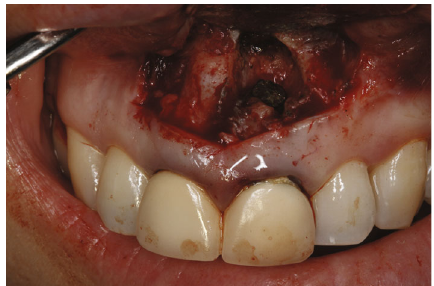
Figure 7: Ostectomy and curettage of the periapical lesions of 1.1 and